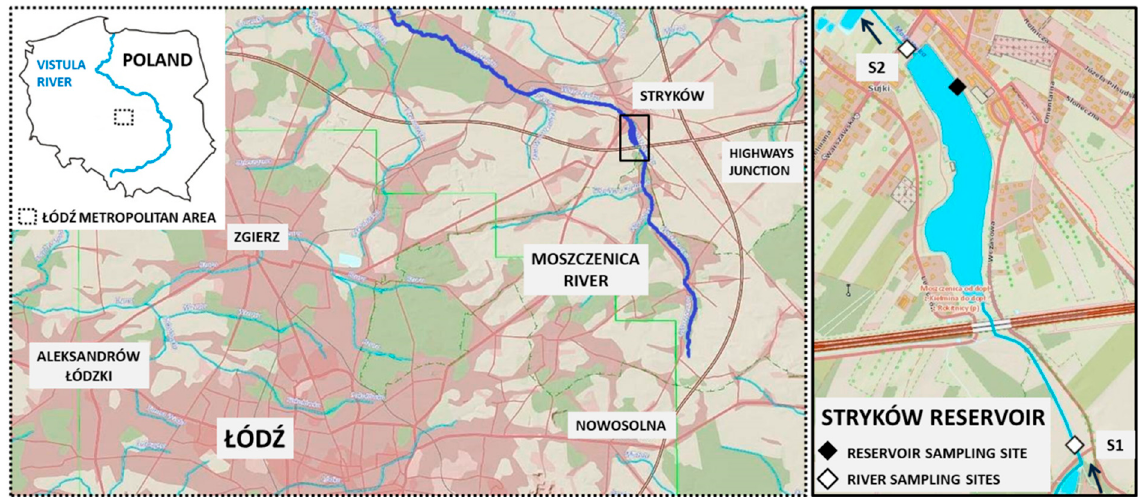
Figure 1. Location of the Stryków artificial reservoir and the study sampling sites; arrows indicate direction of river flow.